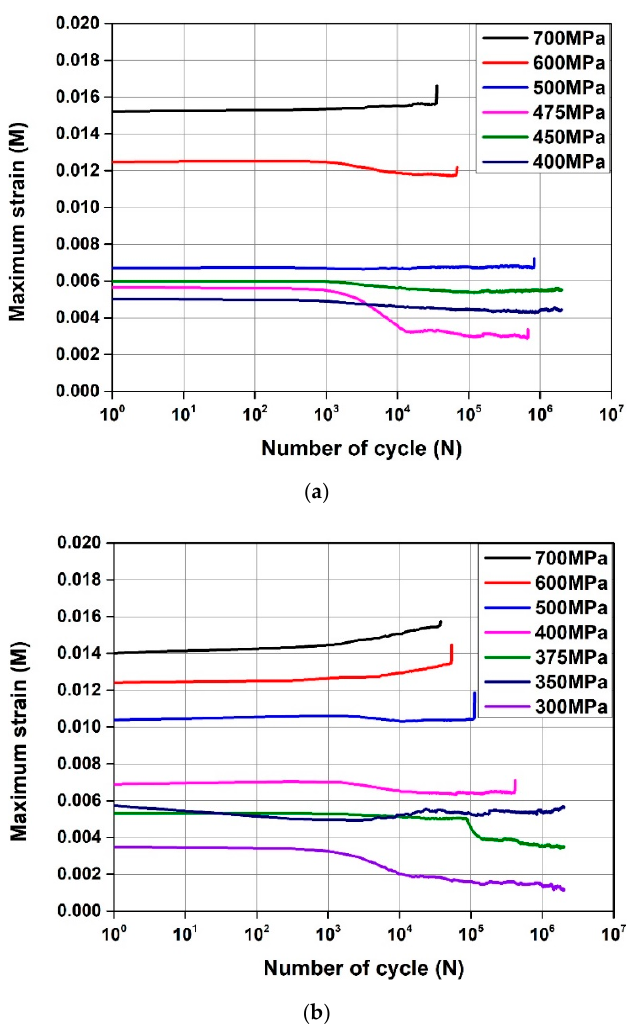
Figure 7. M-N relation according to type of alloy. ( a ) A-type; ( b ) B-type.